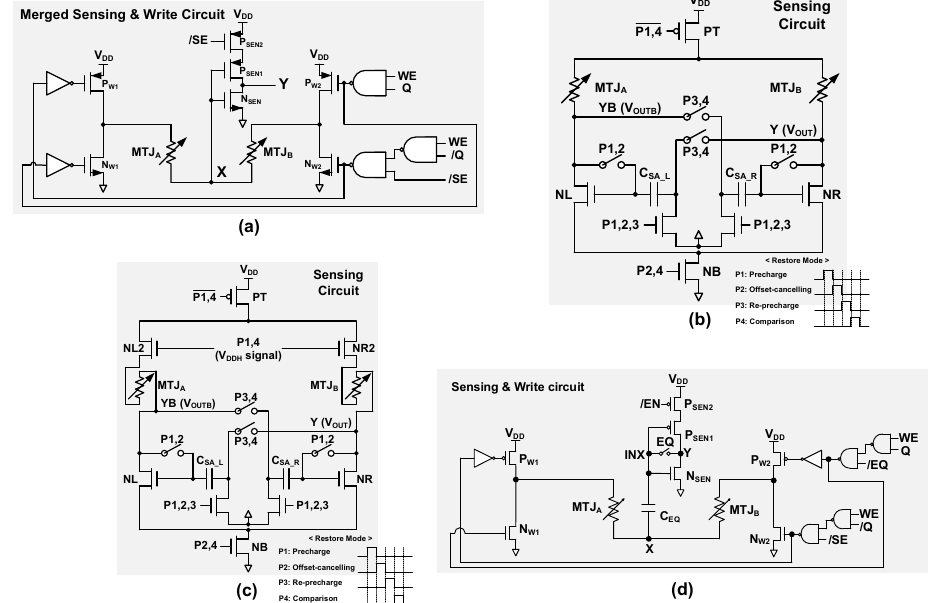
Figure 2. Sensing circuit diagrams of state-of-the-art NVFFs. ( a ) Na et al. [10]. ( b ) Song et al. [11]. ( c ) Na et al. [12]. ( d ) Choi et al. [13].